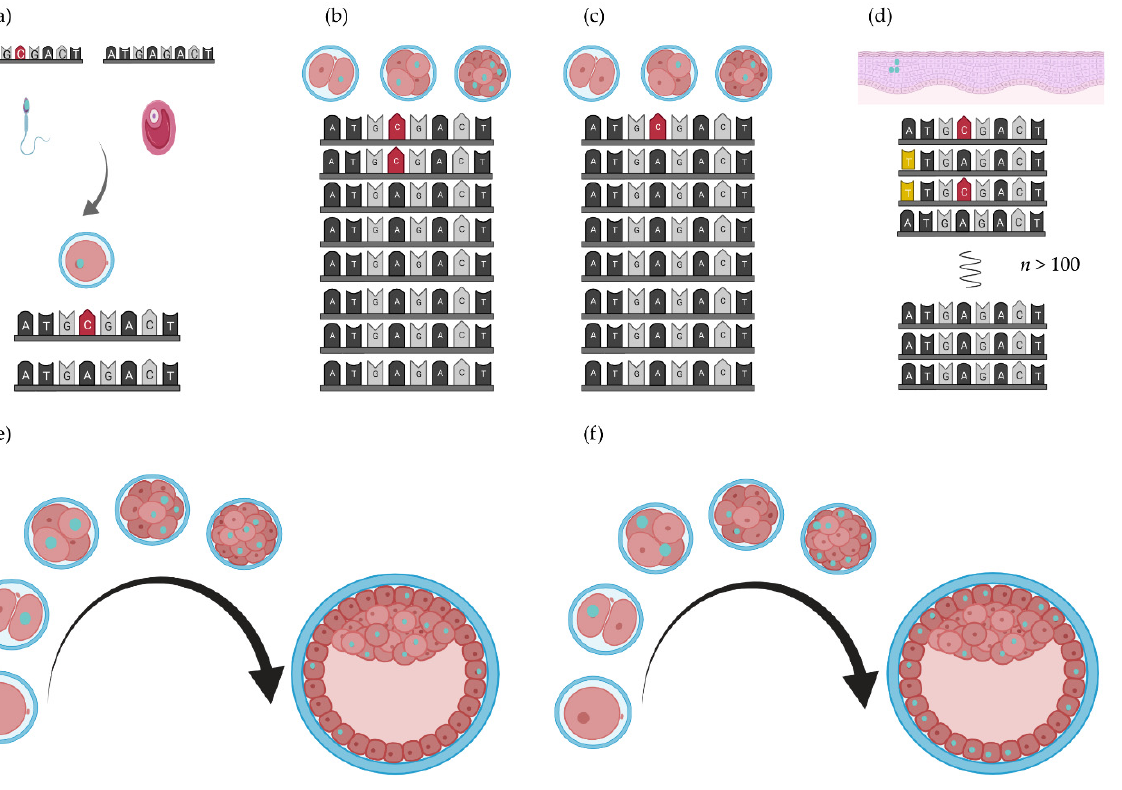
Figure 3. De novo mutation rate and cell fate. The effect of a mutation (opal nuclei) depends on the timing (in what cell stage) and subsequent distribution of these mutated cells in the blastocyst [115] . ( a ) De novo mutation in the gametes